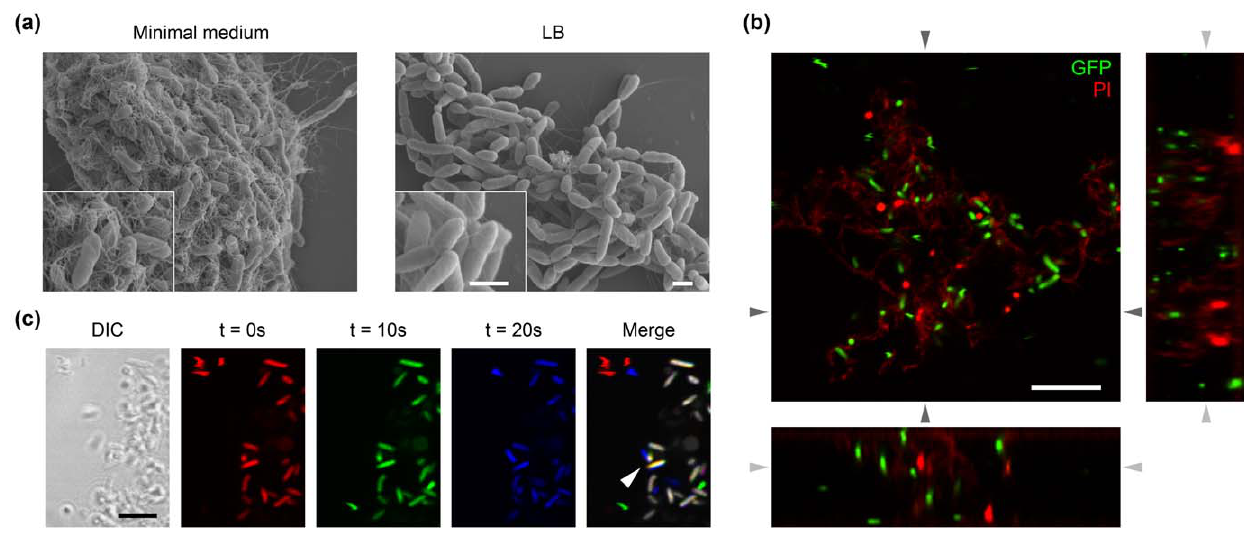
Figure 4. A fibrillar matrix produced invitro by P.syringae pv. aesculi enwraps aggregates of immobilized bacteria. (A) After incubation in minimal medium a fibrillar material covering clustered bacterial cells is observed by scanning electron microscopy (left-hand panel). Such material is not encountered after incubation in LB, wherein only the polar flagella are observed extracellularly (right-hand panel). The insets show the bacterial cells and the surrounding material in more detail. Note that due to the completely dehydrated state of the specimen, the here presented image likely does not depict the true spatial lay-out of a bacterial cluster. The scale bars indicate 1 m m. (B) A typical cluster observed in a PD4818-pMP4655 culture grown in minimal medium visualized by confocal laser scanning microscopy. GFP-expressing bacteria appear in green, while addition of propidium iodide (PI) brightly stained dead individuals red and led to a mild staining of the amorphous material enwrapping the bacteria within a cluster. The bottom and right panels are computed images of the two orthogonal planes along the z-axis indicated by the dark grey arrows. The light grey arrows indicate the position of the optical plane shown in the top left panel. Note that single bacteria are spaced from neighbouring cells in 3 dimensions. The scale bars indicate 10 m m. (C) Three 10 second interval frames taken from a time-lapse movie of the edge of a PD4818-pMP4655 cluster (depicted in the DIC image) were differentially colour coded and merged to reveal displacement of individual bacteria over time. Several motile bacteria freely moved on the left appearing in a single colour in the merged image, while bacteria within the cluster remained at a fixed location as revealed by their white colour in the merged image. Additionally, oscillatory motion of 2 bacteria is discernable in the cluster margin (arrowhead), indicated by the slight colour shift. The scale bar indicates 5 m